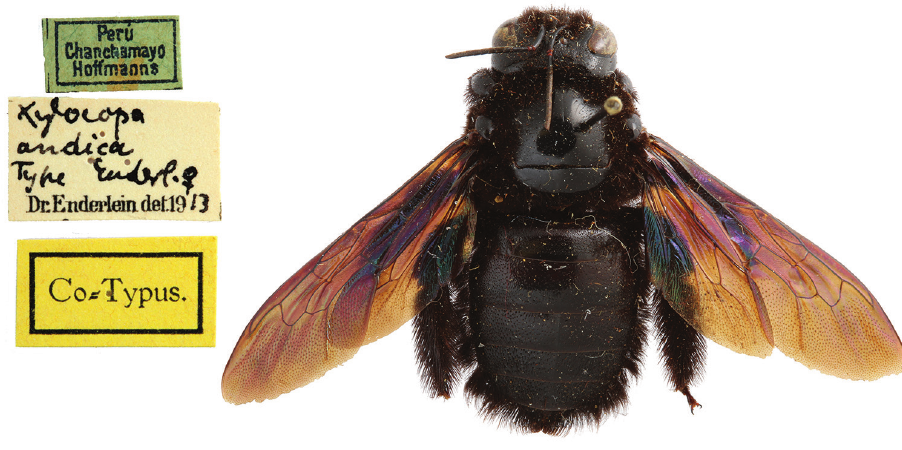
Figure 1. Dorsal habitus of the female lectotype of Xylocopa ( Neoxylocopa ) andica Enderlein. Xylocopa andica was described from five specimens (two females and three males) and no holotype was designated. According to T. Hufleit (MIZ), these syntypes